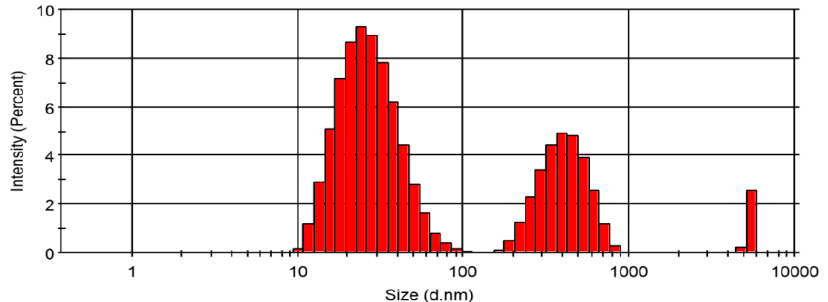
Figure 2. Particle size and distribution of the CPHE phenolic nanopowder.